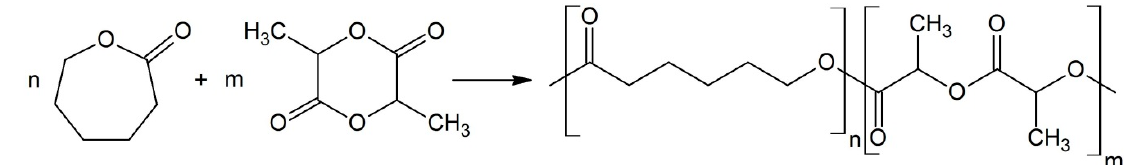
Figure 1. The scheme of copolymerization of rac-LA and CL.